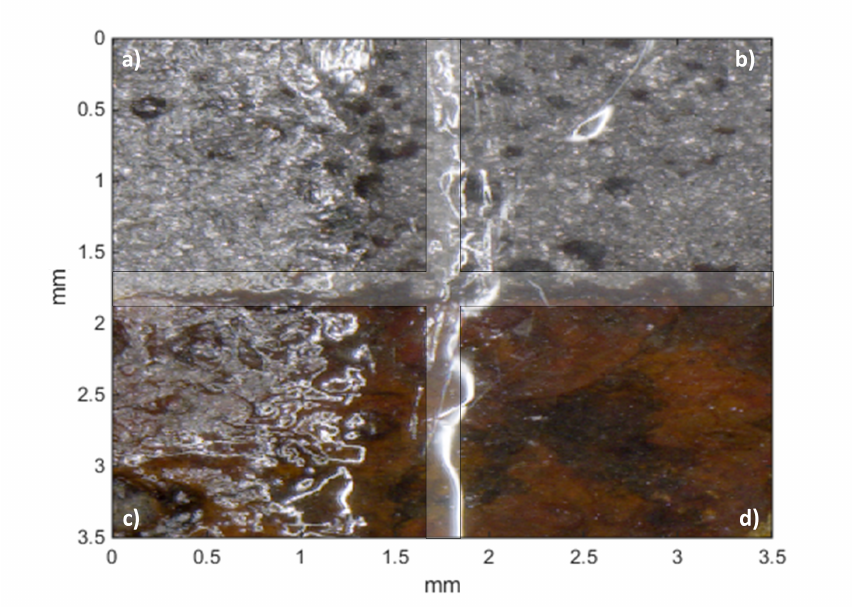
Figure 2. Microscopic image of the customized sectioned sample: ( a ) pure metal; ( b ) pure metal with coating layer on top; ( c ) corroded area; ( d ) corroded material with coating layer on